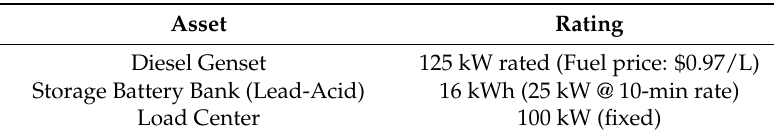
Table 4. Scenario Parameters.